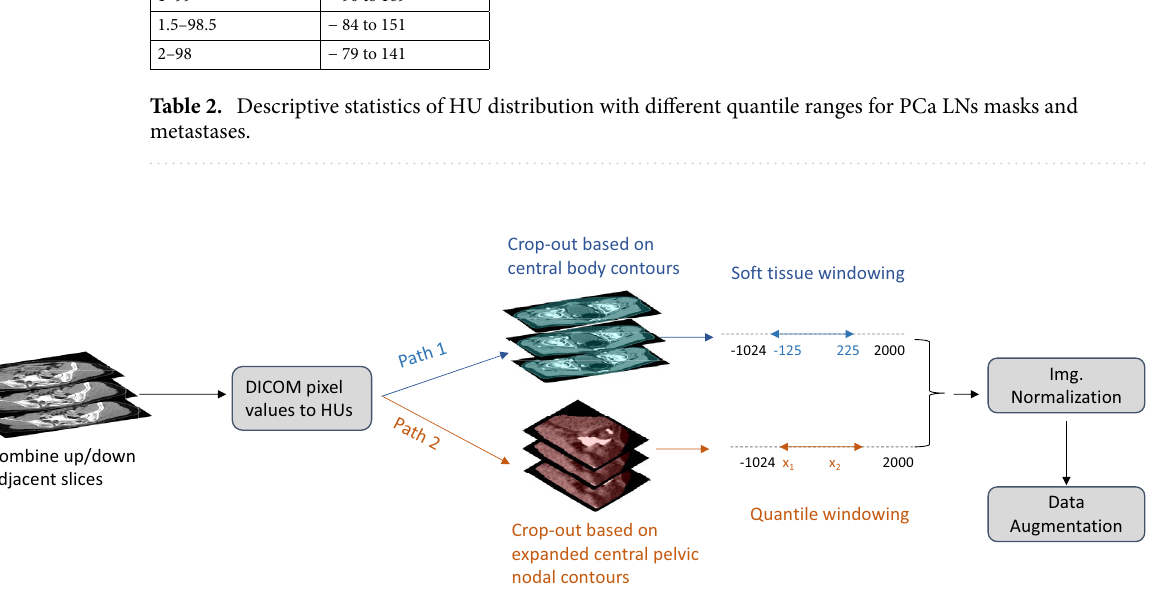
Figure 1. The workflow for data preprocessing. The gray box-bounded steps are identical procedures shared by WSI- as well as Regional-Mask R-CNN. The blue- and brown-marked paths are solely used for WSI- or Regional-Mask R-CNN, respectively. We compressed the shared steps for visualization convenience